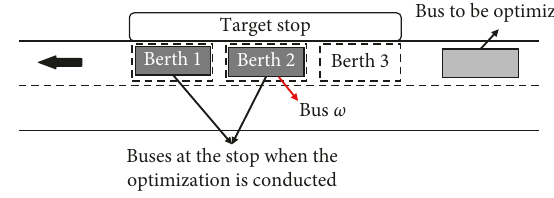
Figure 5: Bus ω when the optimization is